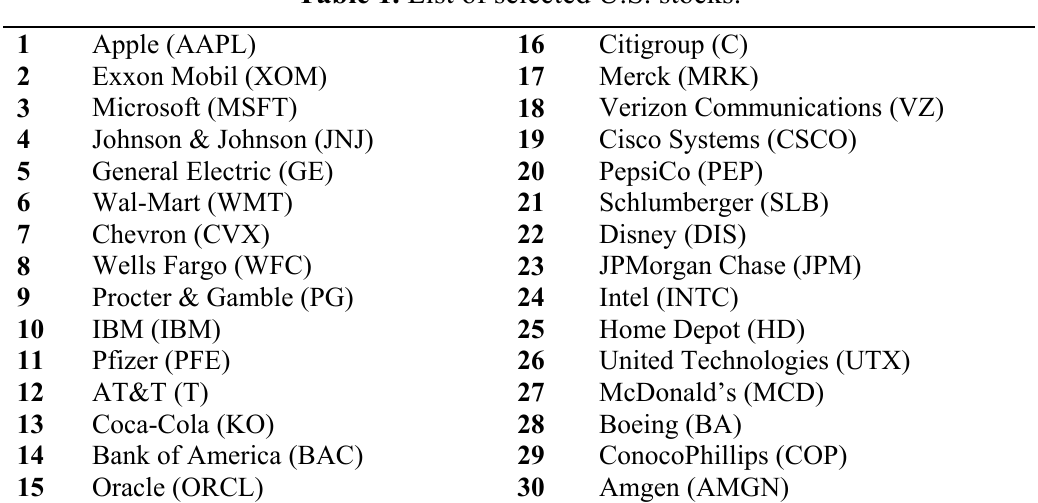
Table 1. List of selected U.S.